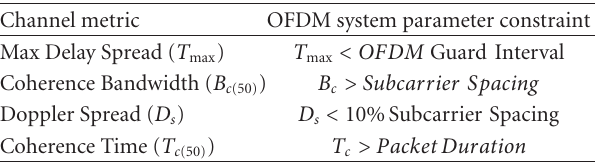
Table 3: OFDM System design parameters.